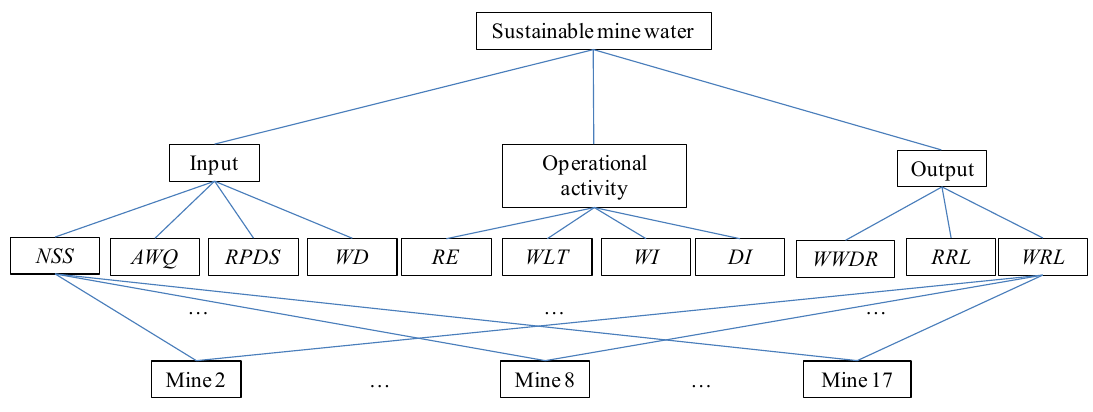
Figure 2. A decision hierarchy of management practice